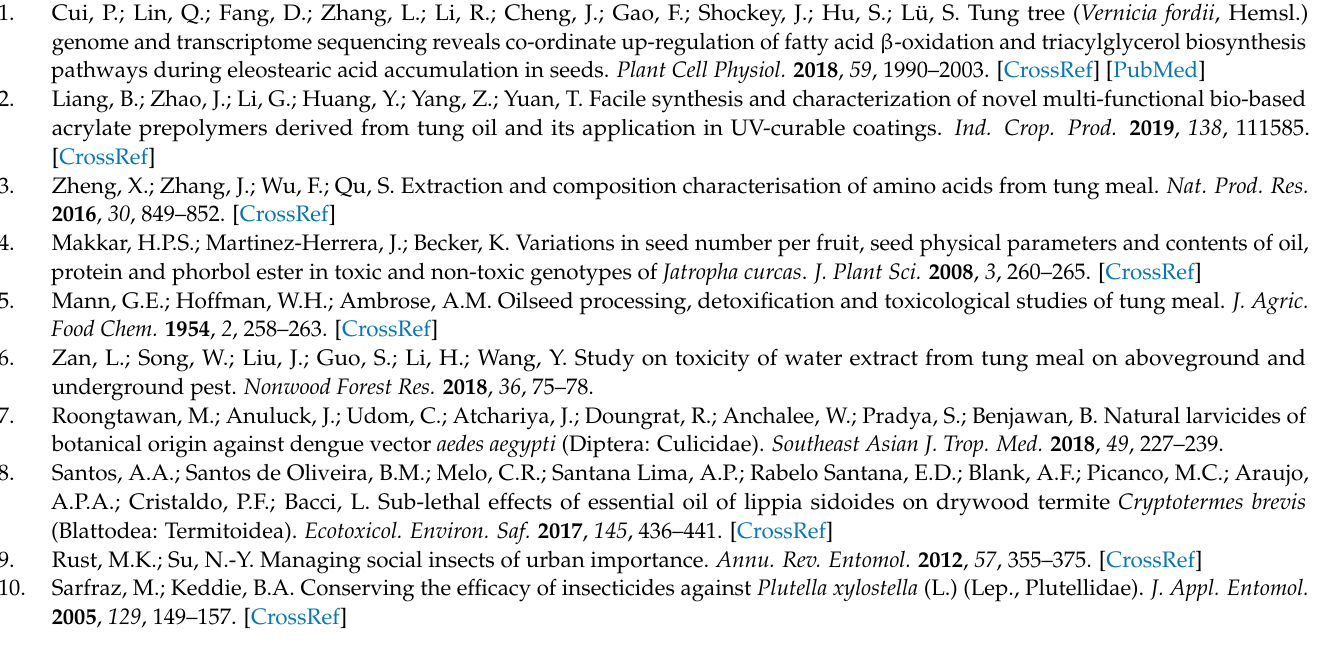
O. formosanus , Figure S1: Insecticidal activity of different tung meal extracts on O. formosanus and P. xylostella . The different letters (a-c) after the mean value represent significant differences at p < 0.05 level according to Duncan